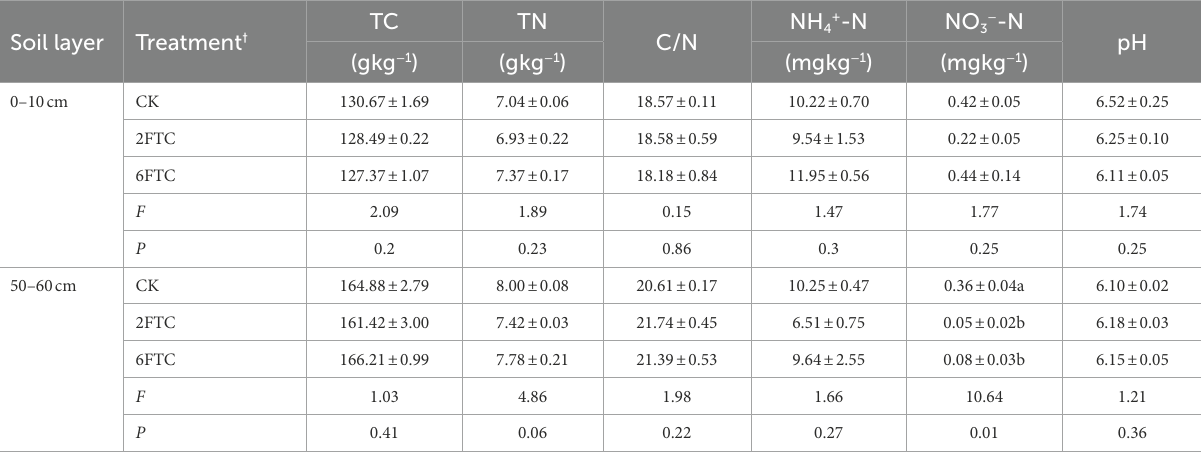
TABLE 1 Soil properties under freeze–thaw treatment at different depths.